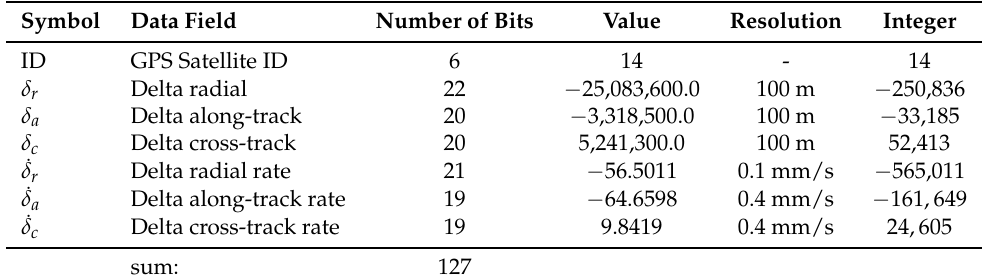
Table 7. Sample modified satellite specific part of RTCM 10,403.2 message 1057.